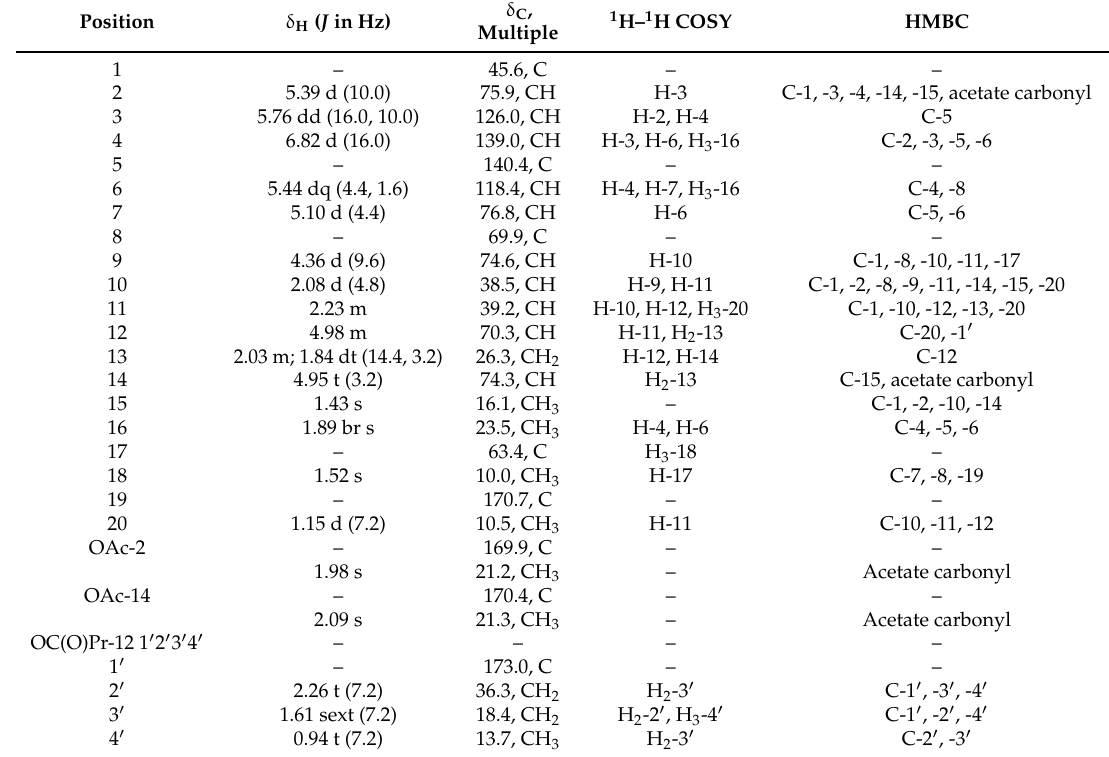
Table 2. 1 H (400 MHz, CDCl 3 ) and 13 C (100 MHz, CDCl 3 ) NMR data and 1 H– 1 H COSY and HMBC correlations for briarane 2 .